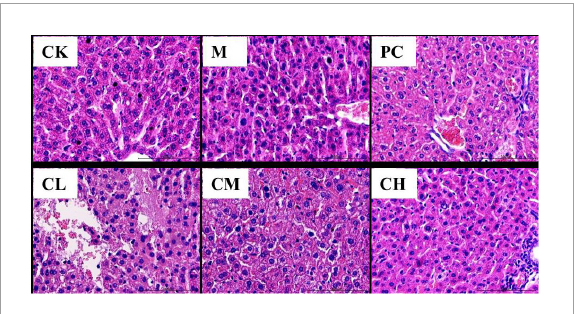
FIGURE1 Histopathological changes in the liver (HE, 200 × ).